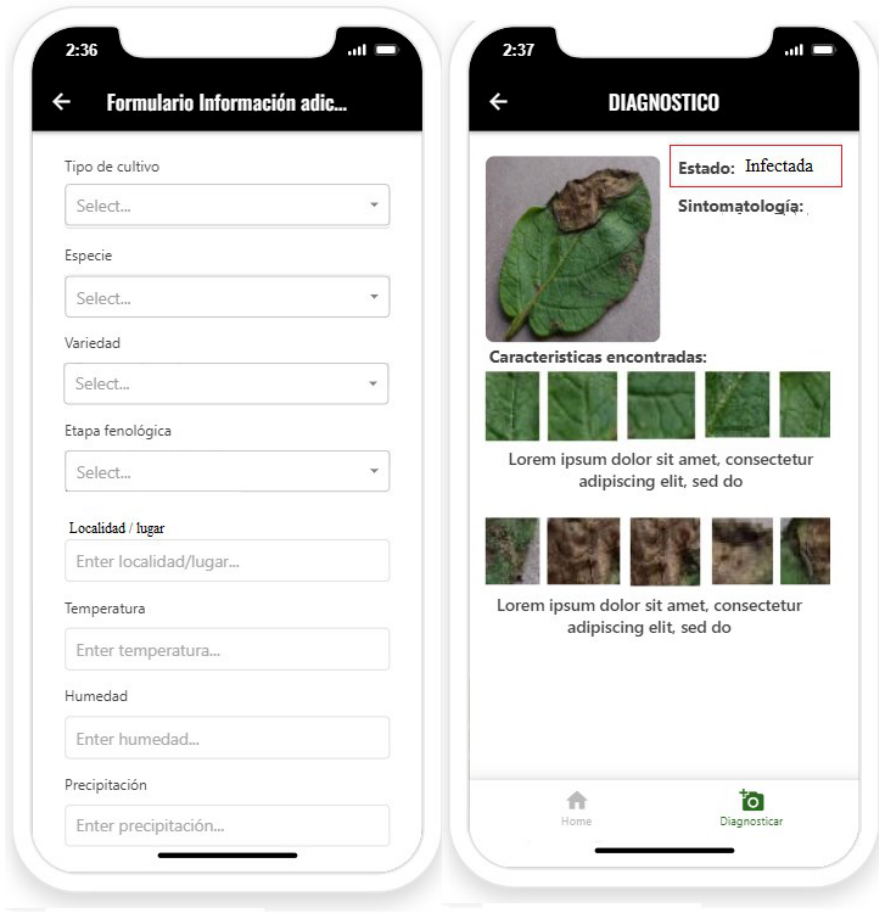
Figure 9. Prototype design for diagnostic visualization of a leaf from an image.